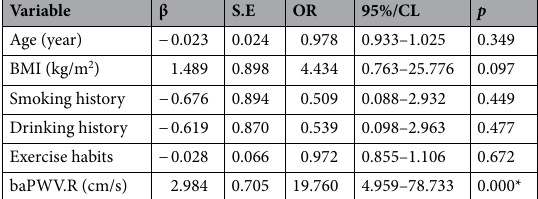
Table 6. Logistic Regression analysis for the association with HSD.